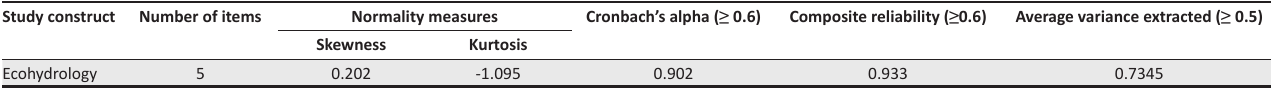
TABLE 2: Normality, reliability and validity of study constructs. Study construct Number of items Normality measures Cronbach’s alpha ( ≥